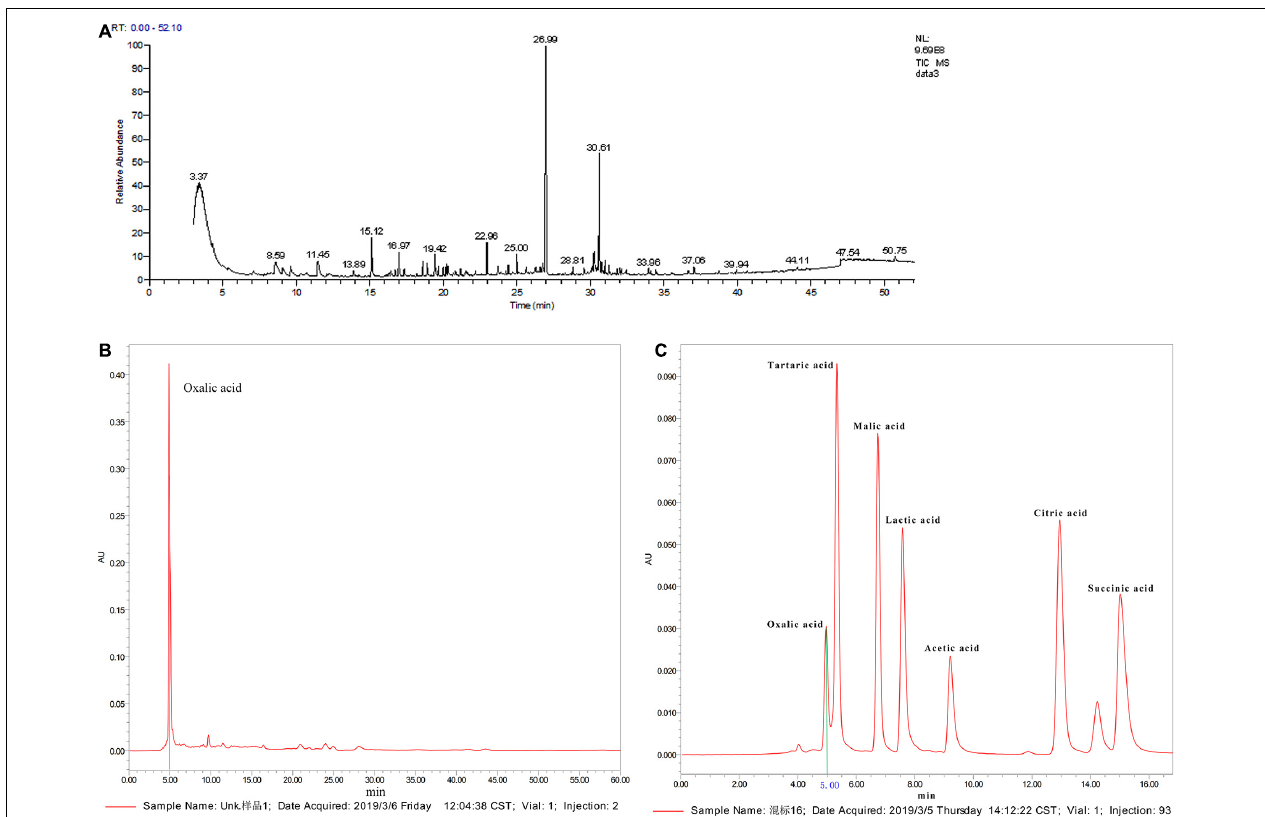
FIGURE 6 | Active ingredient analysis of C3 fermentation broth by GC-MS and HPLC ( A: qualitative analysis on the ethyl acetate extracted samples by GC-MS; B: organic acid standard by HPLC analysis; C: C3 fermentation supernatant by HPLC analysis).